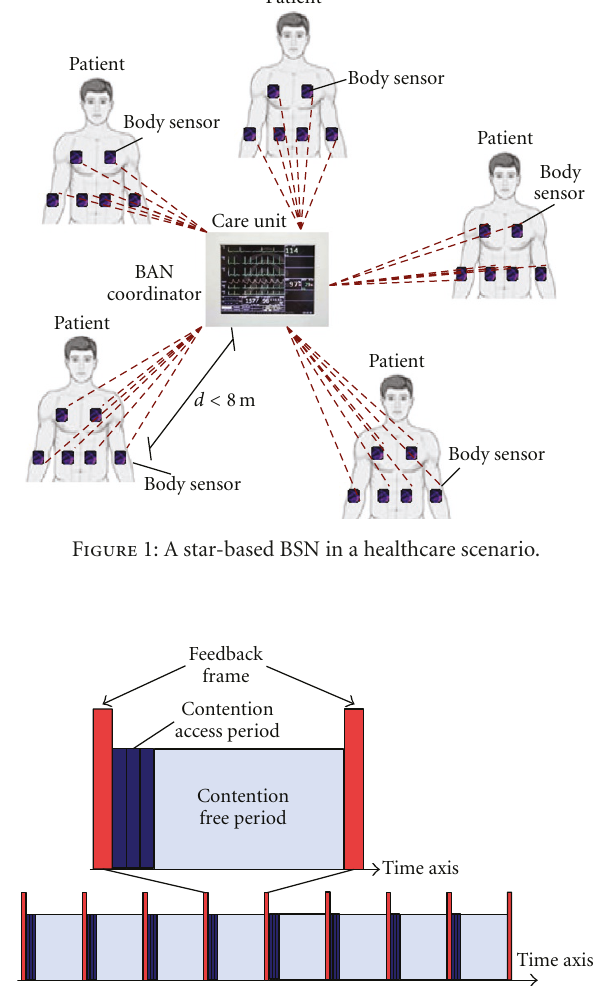
Figure 2: DQ-MAC protocol frame format and time